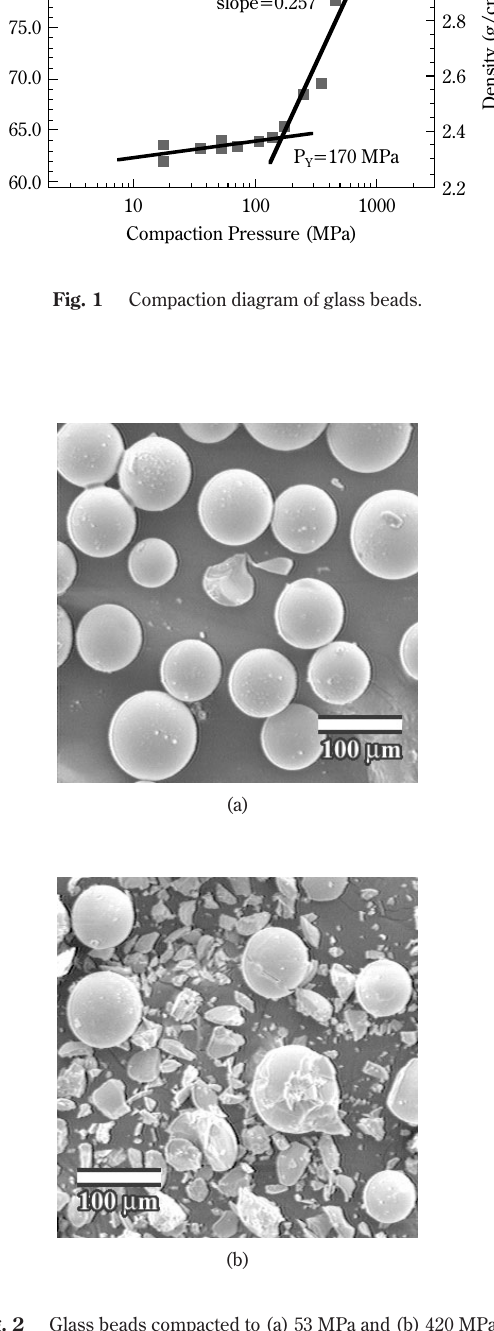
Fig. 2 Glass beads compacted to (a) 53 MPa and (b) 420